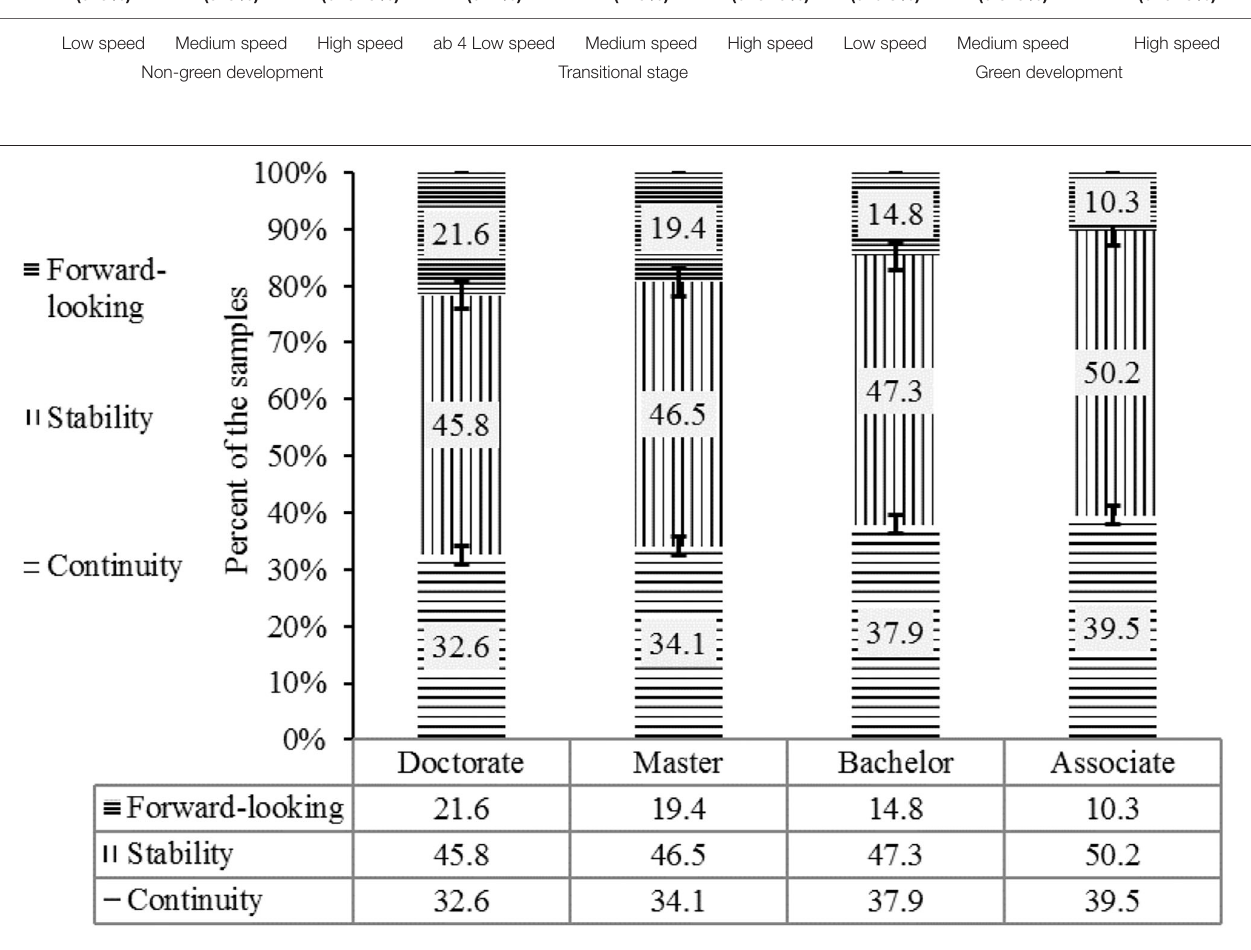
FIGURE 6 | Cognition of policy orientation (PO) at different educated